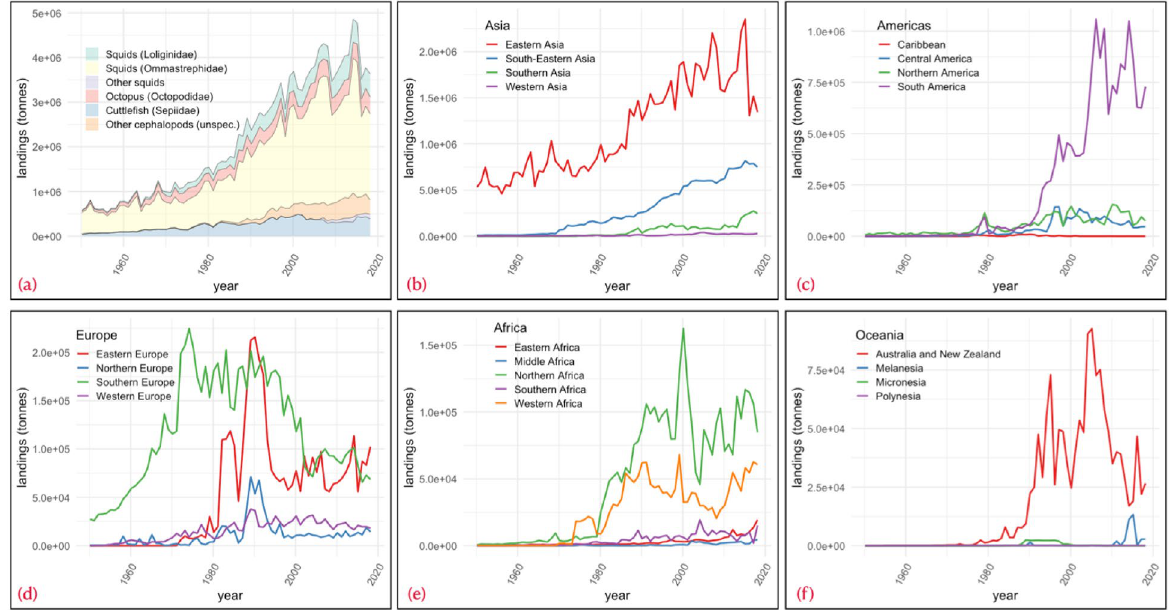
Figure 1. Time series of cephalopod landings by ( a ) taxonomic group and ( b to f ) by continents and sub- continents. Values are given in tonnes. (Data source: FAO 2 . The figure was created with R 12 (https:// cran.r- proje ct. org) package “ggplot2” v.3.2.1 13 (https:// ggplo t2. tidyv erse.